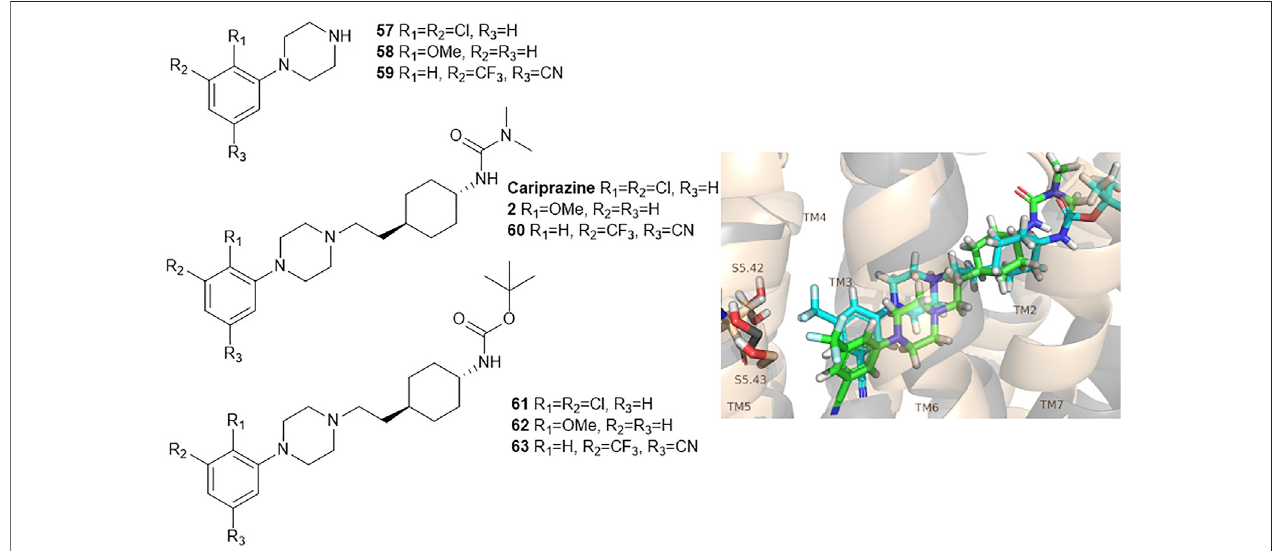
FIGURE 6 | D 2 R and D 3 R ligands with designed functional pro fi le (Egyed et al., 2020). The binding mode of compound 60 and 63 was extracted from the MD simulations. The simulations revealed that the SP motif in fl uence the position of the PP and that might be linked to the observed different functional pro fi le. The fi gure representing the binding mode is reproduced from the TOC Figure of our original article Egyed, A et al. Controlling Receptor Function from the Extracellular Vestibule of G-Protein Coupled Receptors. Chem. Commun. 2020, 56 (91), 14167 – 14170.